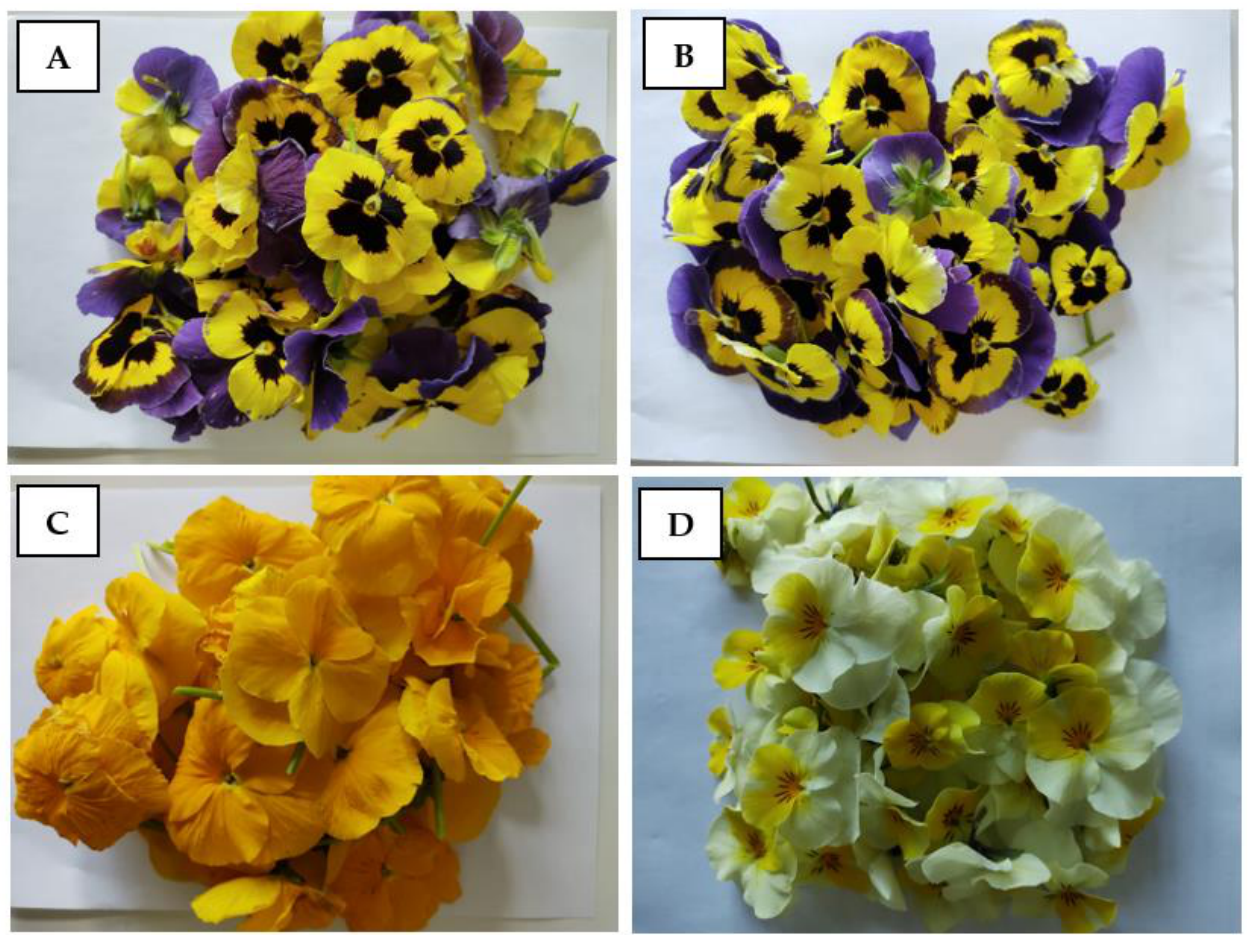
Figure 2. Conventional double-pigmented pansy flowers: yellow/violet ( A ); organic double-pigmented, yellow/violet pansy flowers ( B ); conventional, one-pigmented, yellow pansy flowers ( C ); and organic, one-pigmented, yellow pansy flowers ( D ).